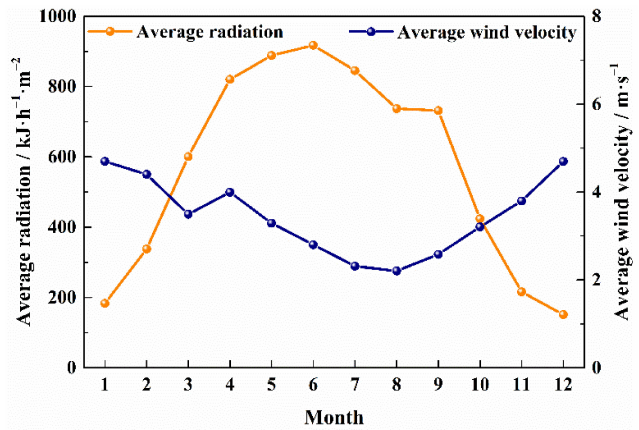
Figure 8. Monthly average radiation and wind velocity in Kaba-He.